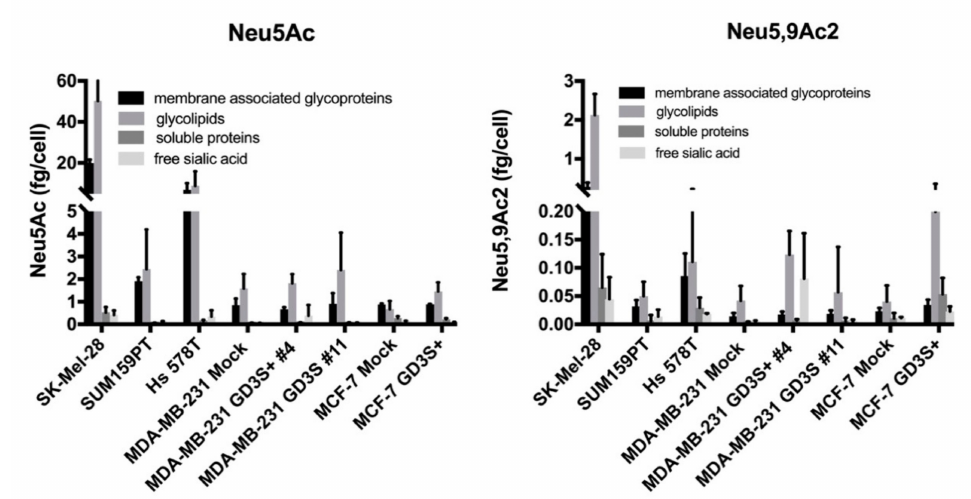
Figure 2. Neu5Ac and Neu5,9Ac 2 DMB-Sia derivatives quantification by LC-ESI / MS in di ff erent cell fractions. Cell pellets were fractionated into membrane associated glycoproteins, glycolipids, soluble proteins, and free sialic acid fractions and hydrolyzed by propionic acid. The extracted sialic acids were derivatized using DMB and injected into LC-ESI / MS for identification and quantification. The amounts of Neu5Ac and Neu5,9Ac 2 were quantified by integrating the corresponding areas obtained using extracted ion chromatogram on DMB-Sia derivatives. Each bar represents the mean of three independent